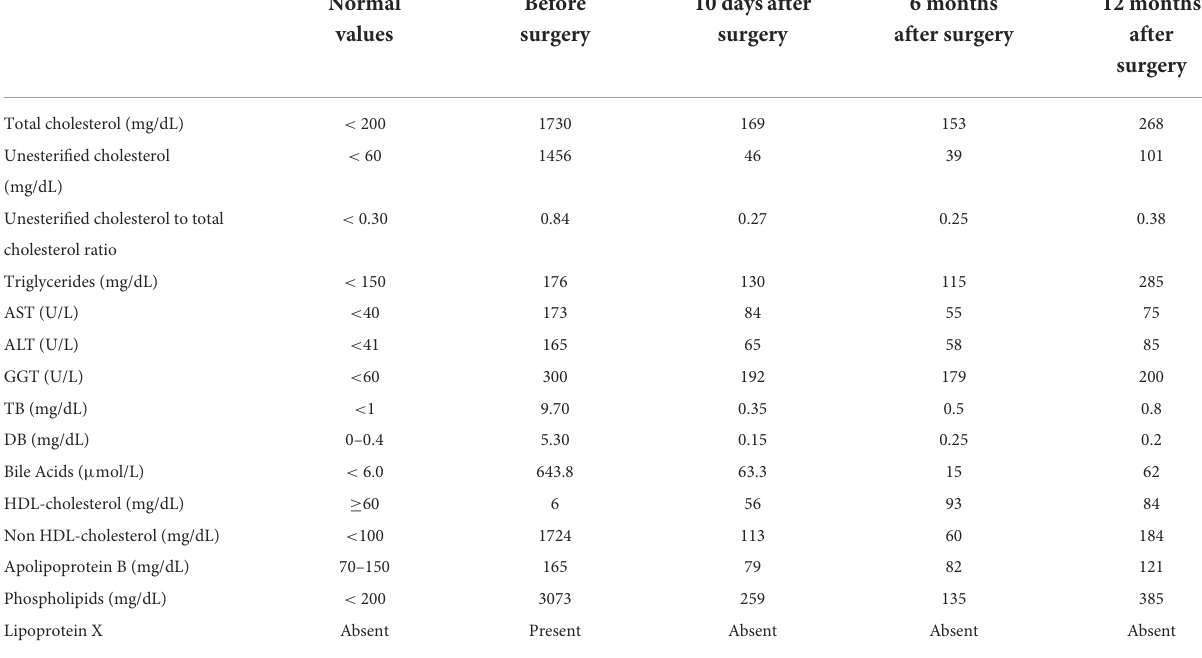
TABLE 1 Cholestasis parameters and lipid profile before/after surgery, and during follow up.